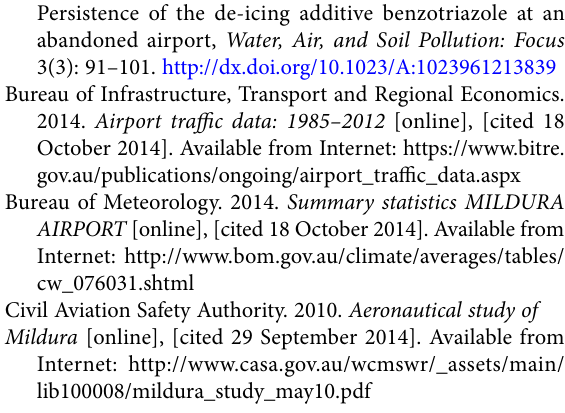
Fig. 7. The average monthly rainfall (averaged from 1947 until 2013) for Mildura Airport (Bureau of Meteorology